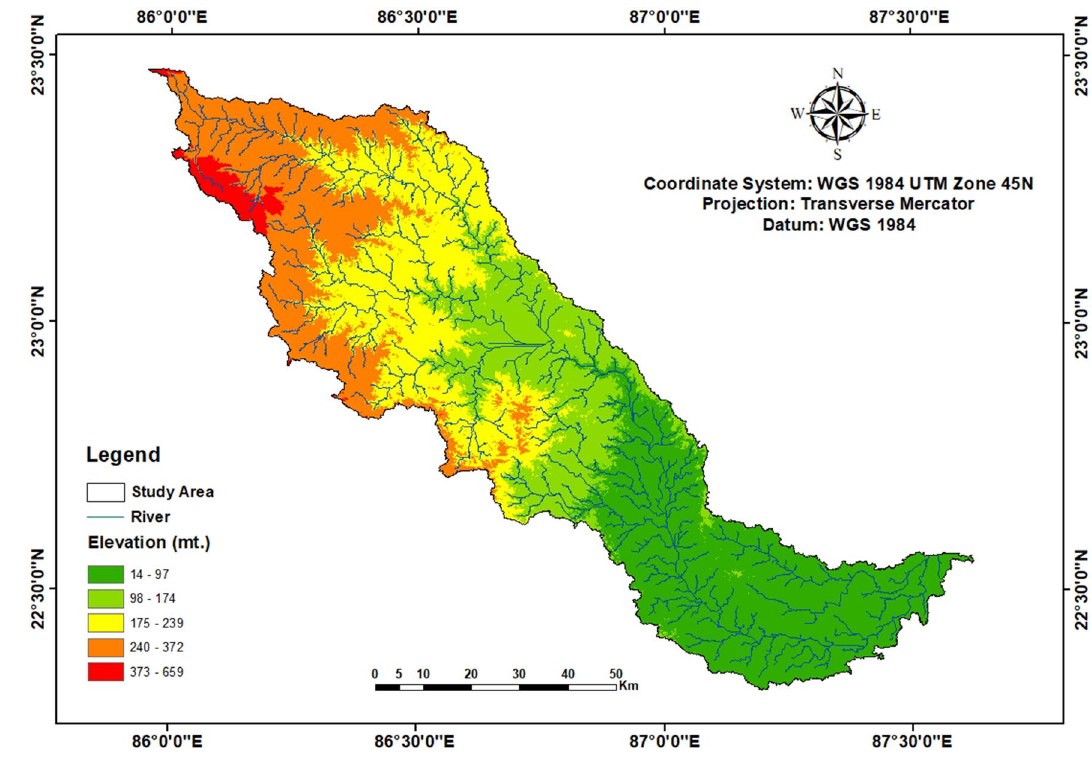
Fig. 7 Spatial distribution of elevation of lands within Kangsabati River